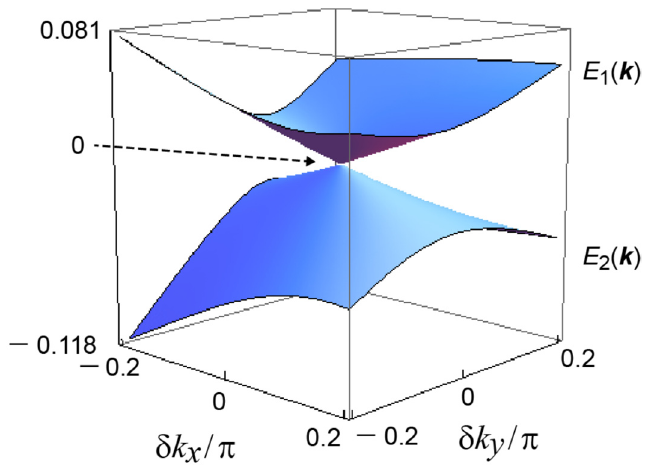
Figure 10. A characteristic curvature of the band structure, which is referred to as a Dirac cone. A close-up view around one of the two Dirac points, shown by 0 in the figure. The band structure was calculated for α -STF 2 I 3 . Reproduced from Ref. [920] with permission.